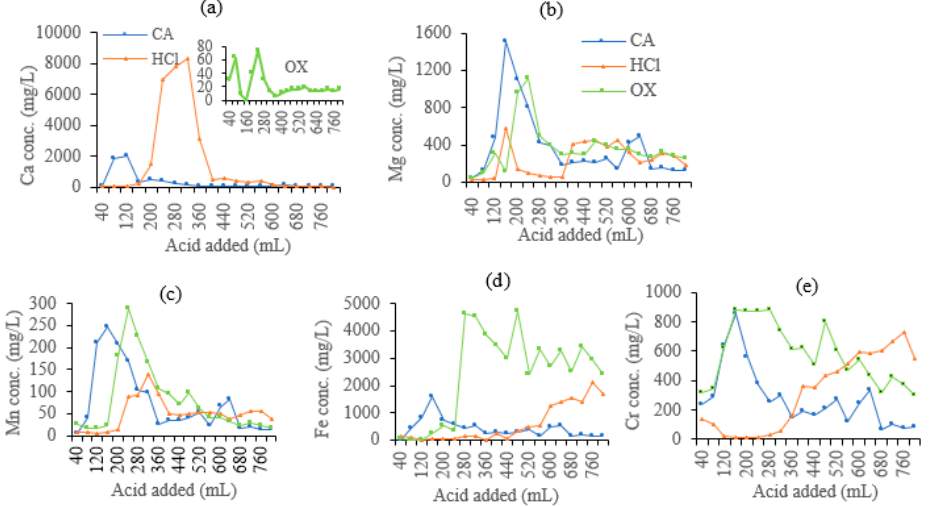
Figure 3. Dynamic concentrations of metals in leachates of the soils leached by different acids. ( a ) Ca, ( b ) Mg, ( c ) Mn, ( d ) Fe, ( e ) Cr.